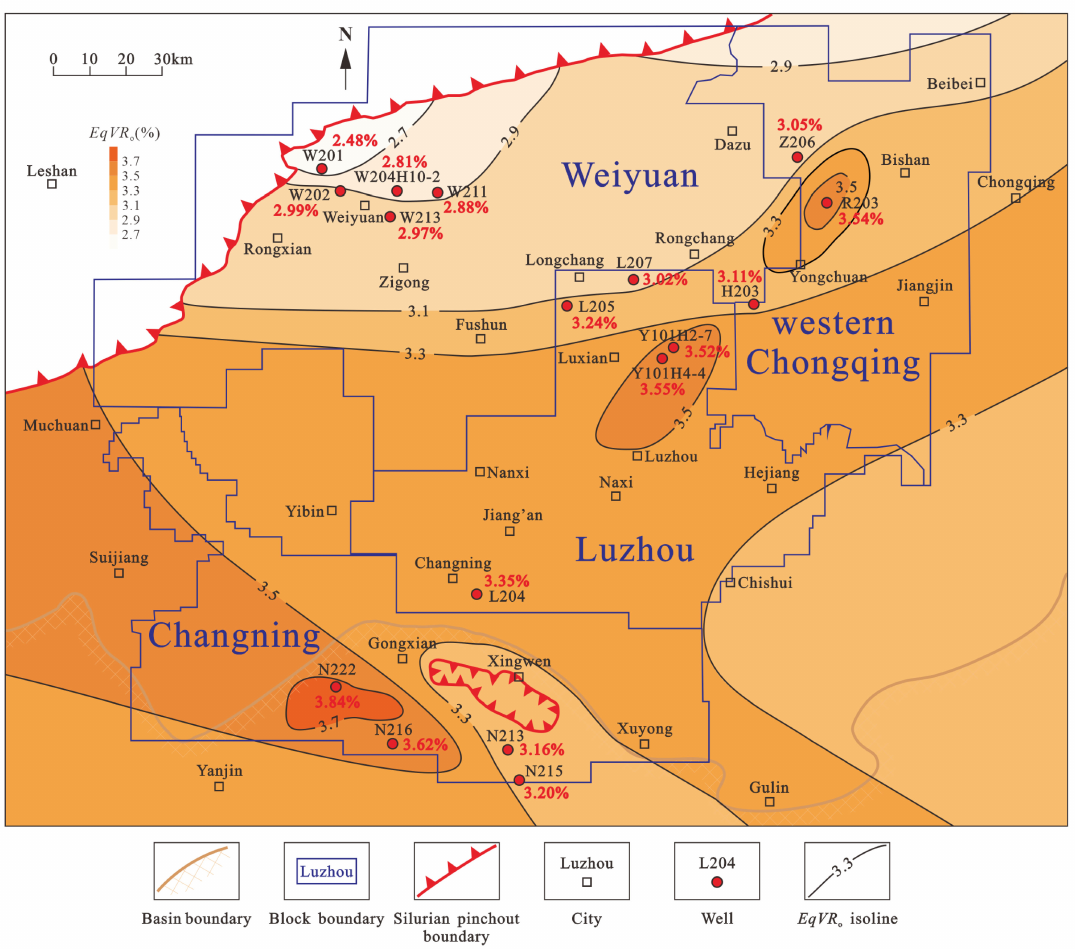
Figure 13. Equivalent vitrinite reflectance of the Wufeng–Longmaxi Shale in southern Sichuan